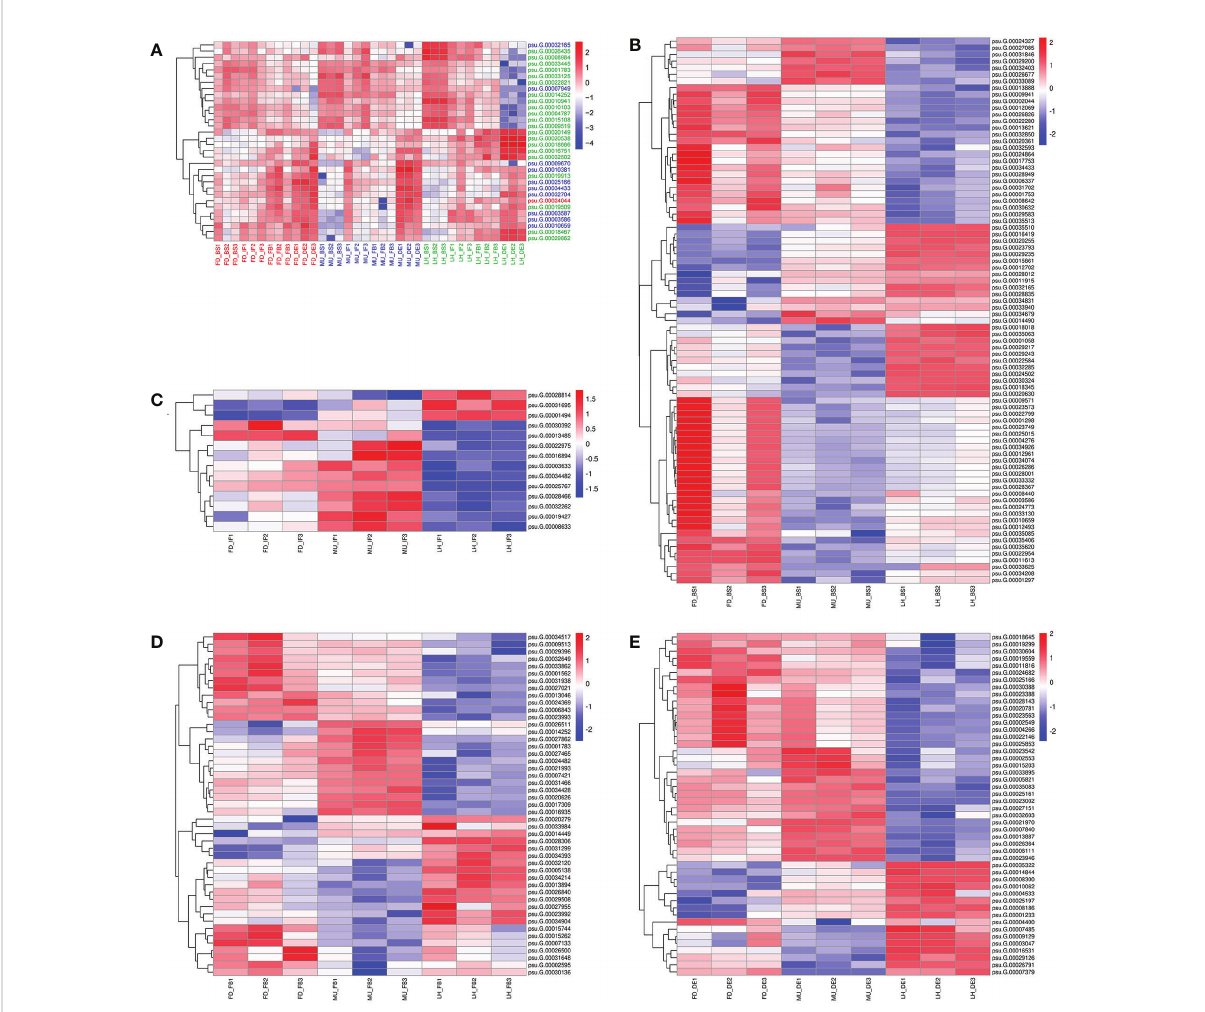
FIGURE 6 Expression pattern of miRNA targets speci fi c to fl ower developmental stages and varieties by miRNAome, transcriptome and degradome integrated analysis of tree peony. (A) Expression pattern of miRNA targets identi fi ed across fl ower developmental stages in FD, MU, and LH. (B) Expression pattern of miRNA targets identi fi ed across tree peony varieties at fl ower developmental stage BS. (C) Expression pattern of miRNA targets identi fi ed across tree peony varieties at fl ower developmental stage IF. (D) Expression pattern of miRNA targets identi fi ed across tree peony varieties at fl ower developmental stage FB. (E) Expression pattern of miRNA targets identi fi ed across tree peony varieties at fl ower developmental stage